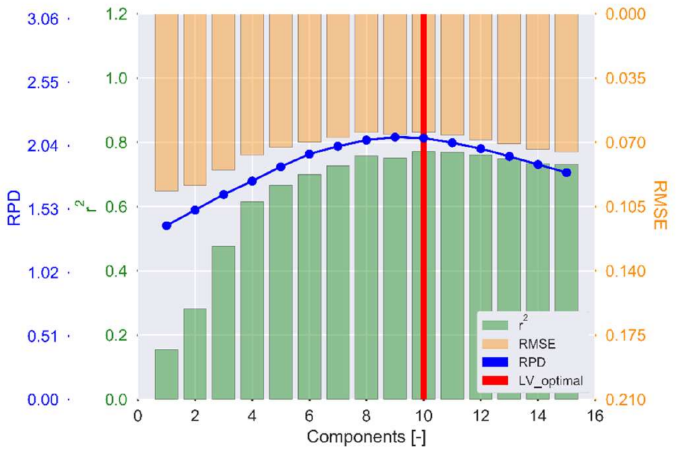
Figure 3. RMSE, r 2 and RPD vs. PLS components for